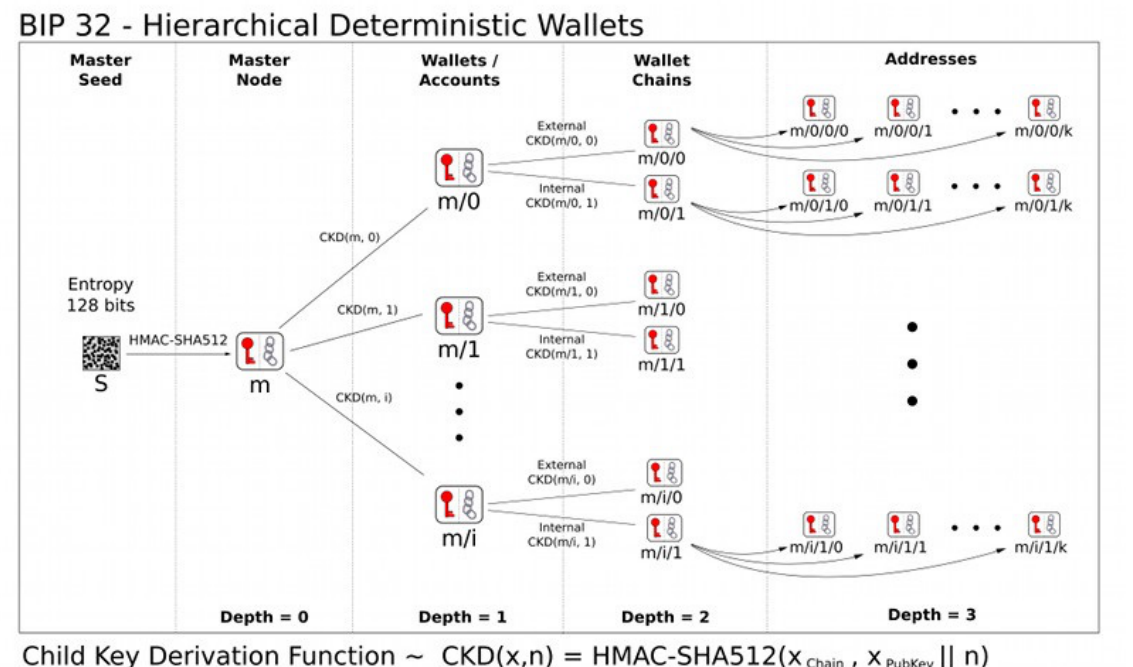
Figure 4. Hierarchical Deterministic wallet derivation